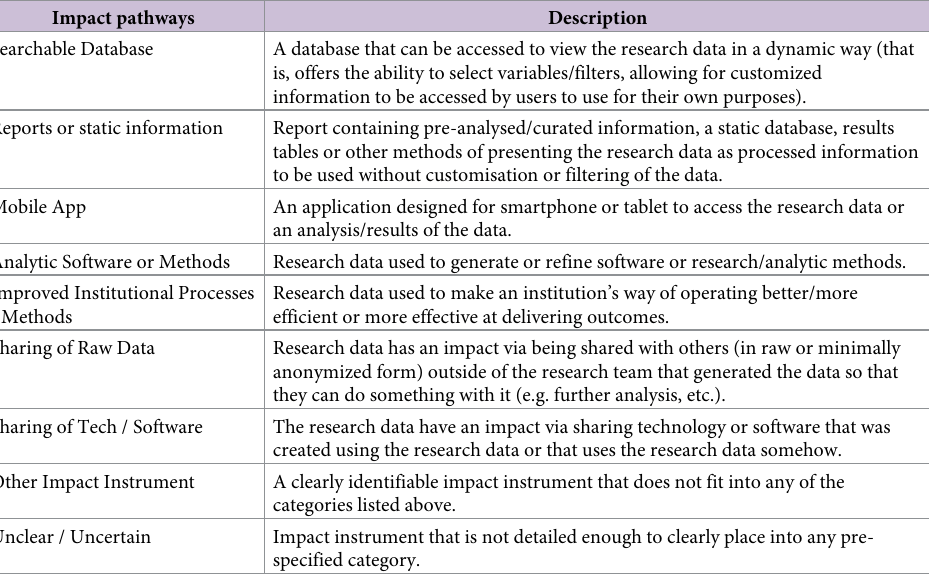
Table 5. Identified ways of developing impact, or impact